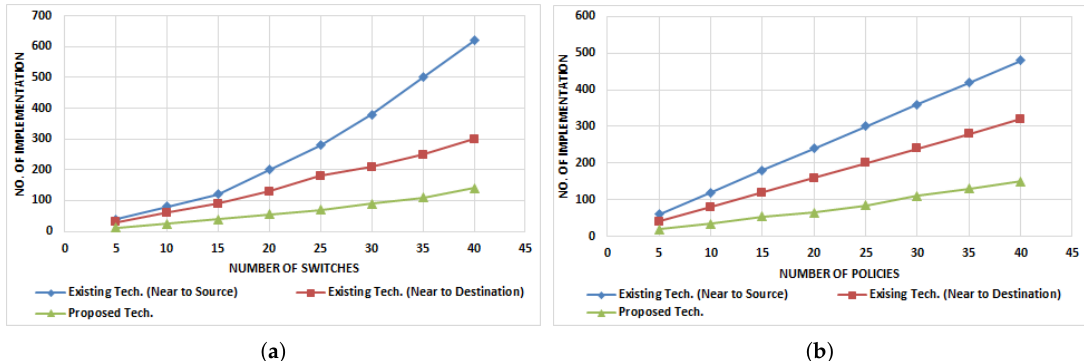
Figure 21. Simulation results of proposed and existing approaches for No. of ACL Implementations. ( a ) Number of ACL implementations against a number of ACL policies when the number of switches is varying; ( b ) Number of ACL implementations against number of ACL policies when number of policies is